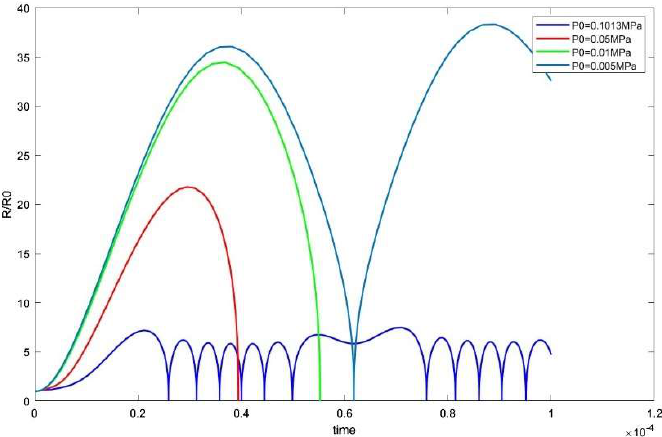
Figure 6. The size of cavitation bubble under different pressure P (cid:48) .